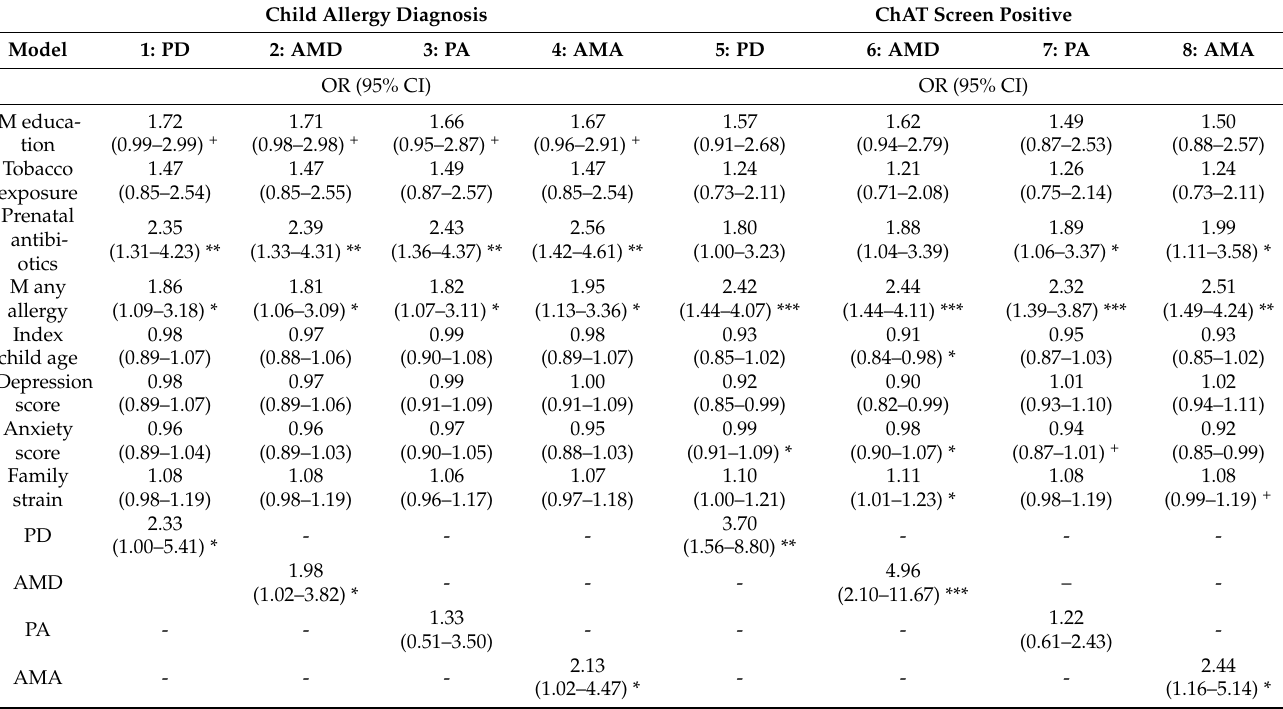
Table 3. Logistic regression models of exposure to maternal distress (perinatal and any time) and family strain adjusted for potential